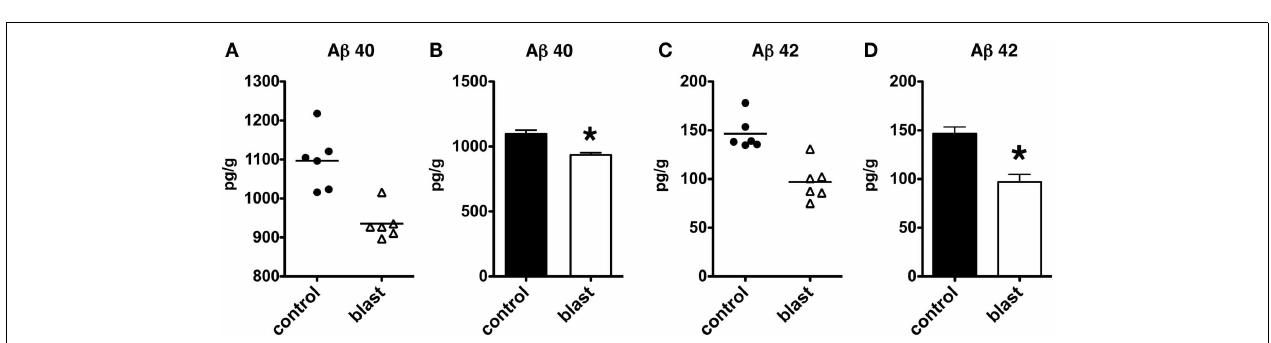
consisted of sham exposed mice.Values are presented the ± SEM. Asterisk indicates values that were significantly different from controls (unpaired t -tests). Note the reduction in A β 40 and